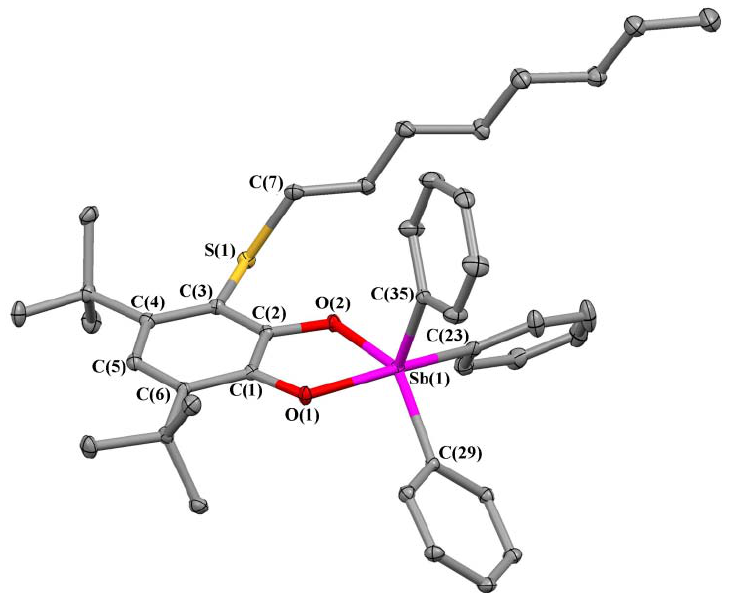
Figure 3. The X-ray structure of (3-OctS-4,6-Cat)SbPh 3 ( 3 ). Hydrogen atoms are omitted, ellipsoids of 30% probability.